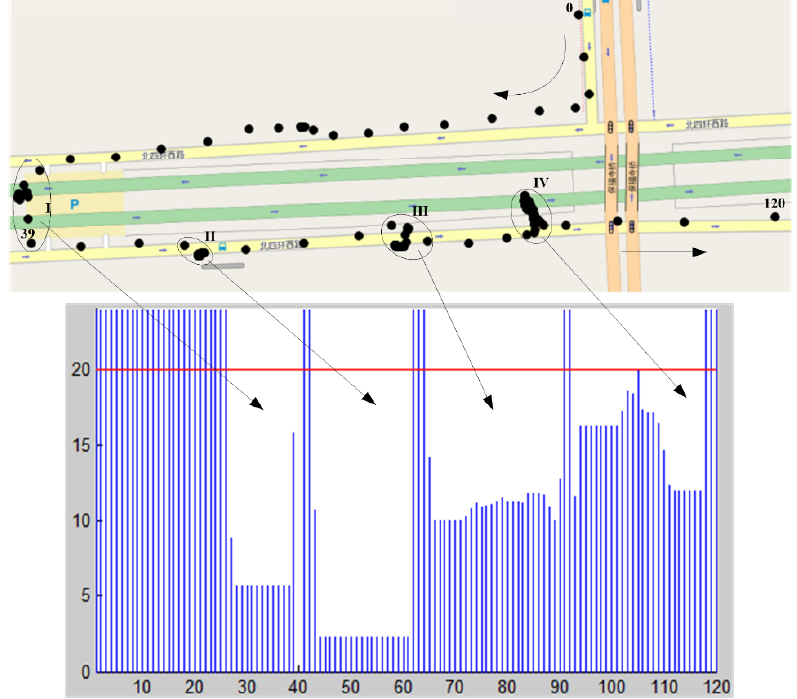
Figure 4. An example reachability graph with respect to Eps = 20m and Tau = 50s.